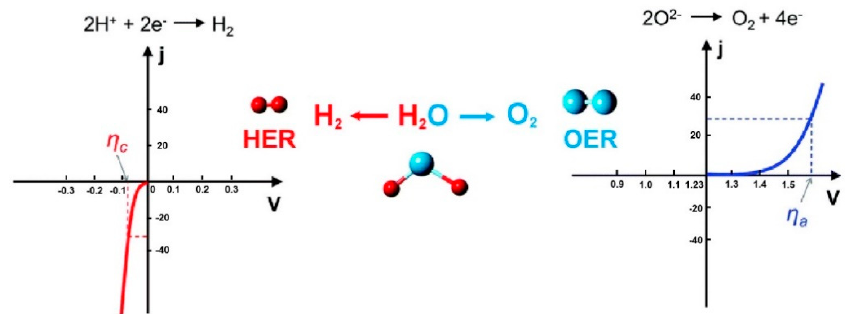
η η c and a represent the overpotential